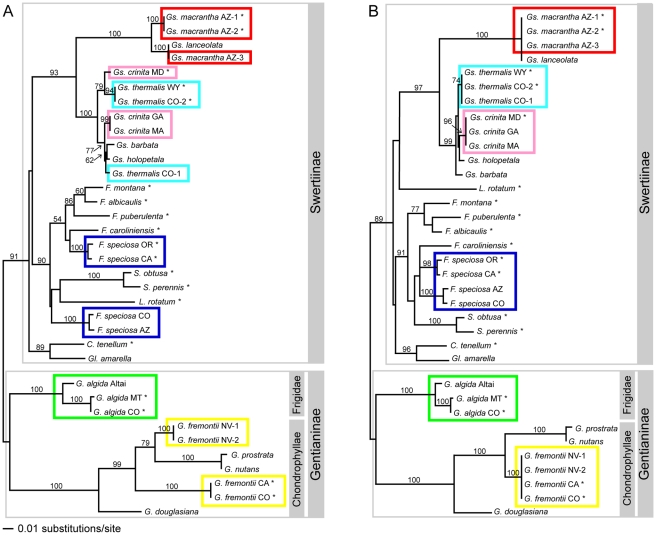
Neighbor-joining trees resulting from two treatments of trnH-psbA inversion.(A) NJ tree resulting from analysis of unedited raw sequence matrix, in which different taxa have either one or the other of two inversion configurations, and (B) NJ tree resulting from analysis of unedited uniform inversion matrix, in which the loop region of sequences with the A configuration has been replaced with its reverse complement. Conspecific sequences are indicated in colored boxes. Gs.  =  Gentianopsis, F.  =  Frasera, S.  =  Swertia, L.  =  Lomatogonium, C.  =  Comastoma, Gl.  =  Gentianella, G.  =  Gentiana. Two subtribes of Gentianaceae and two sections of Gentiana are indicated in gray boxes. Sequences with the A configuration are noted with an asterisk. Bootstrap values >50% are given above branches. The scale bar refers to both trees.